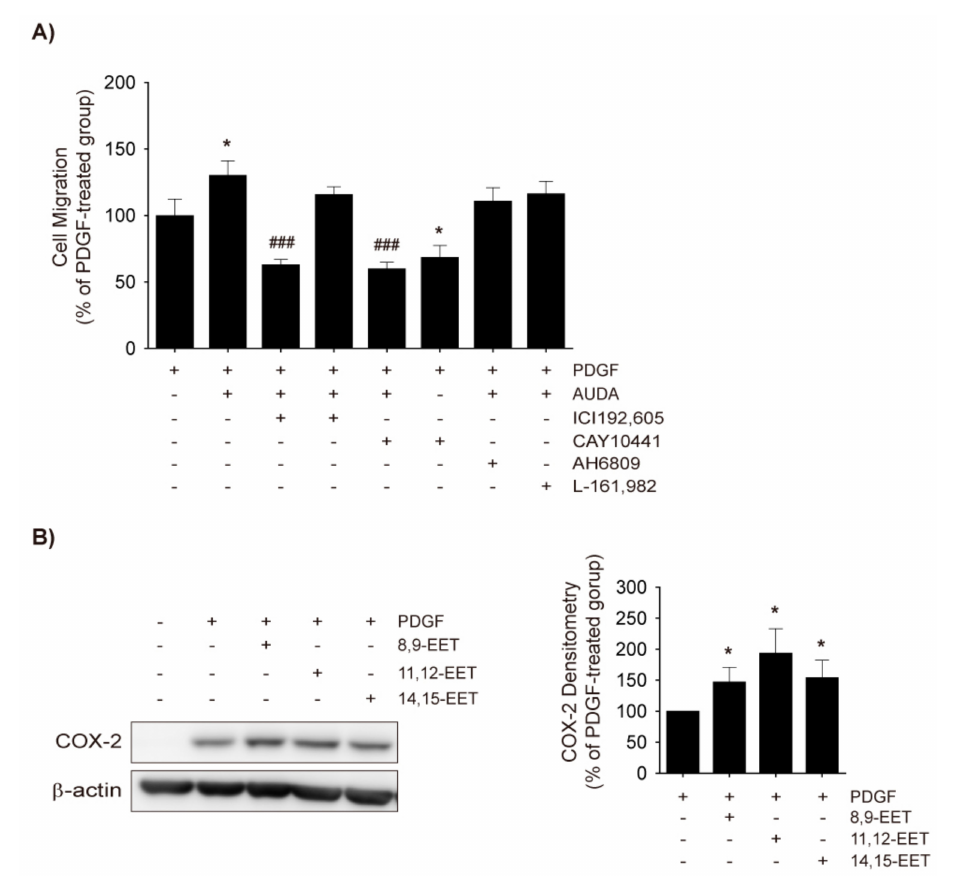
Figure 5. Role of thromboxna A2 (TXA 2 ) in AUDA-stimulated VSMC migration. ( A ) Effects of prostanoid receptor antagonists on AUDA-stimulated VSMC migration. Rat VSMCs were treated with vehicle control, TXA 2 receptor (TP) antagonist ICI192,605 (10 µ M), PGI 2 receptor (IP) antagonist CAY10441 (10 µ M), EP1, EP2, EP3, and PGD 2 receptor (DP)1 antagonist AH6809 (10 µ M), or PGE 2 receptor (EP) 4 antagonist L-161,982 (10 µ M) in the presence or absence of AUDA (10 µ g/mL) for 24 h. Cell migration was determined via Boyden chamber assay. Culture media containing 30 ng/mL PDGF was added to the lower chamber as chemoattractant; ( B ) Effects of EETs on COX-2 expression in VSMC. Rat VSMCs were preincubated with vehicle control, 8,9-EET, 11,12-EET, or 14,15-EET (1 µ M) for 30 min and then exposed to 30 ng/mL PDGF for 8 h. COX-2 expression in total cell lysates was assessed by immunoblotting ( n = 3). Statistical significance is indicated as * p < 0.05 vs. PDGF-treated group; ### p < 0.001 vs. PDGF+AUDA-treated